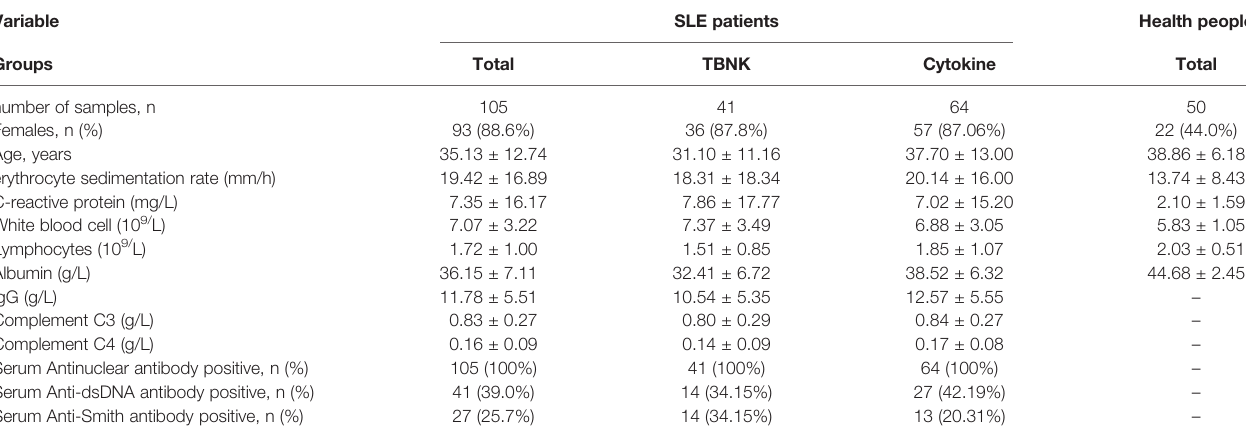
TABLE 1 | General information of SLE patients and healthy people. Variable SLE patients Health people Groups Total number of samples,